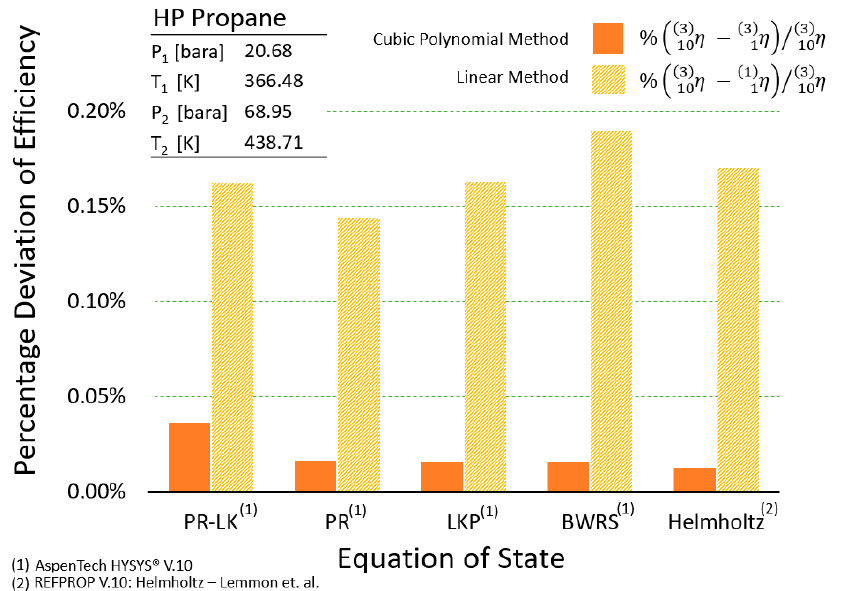
( 1 ) ( 3 ) η , and cubic polynomial, η , 1 1 ( 3 ) η , 10